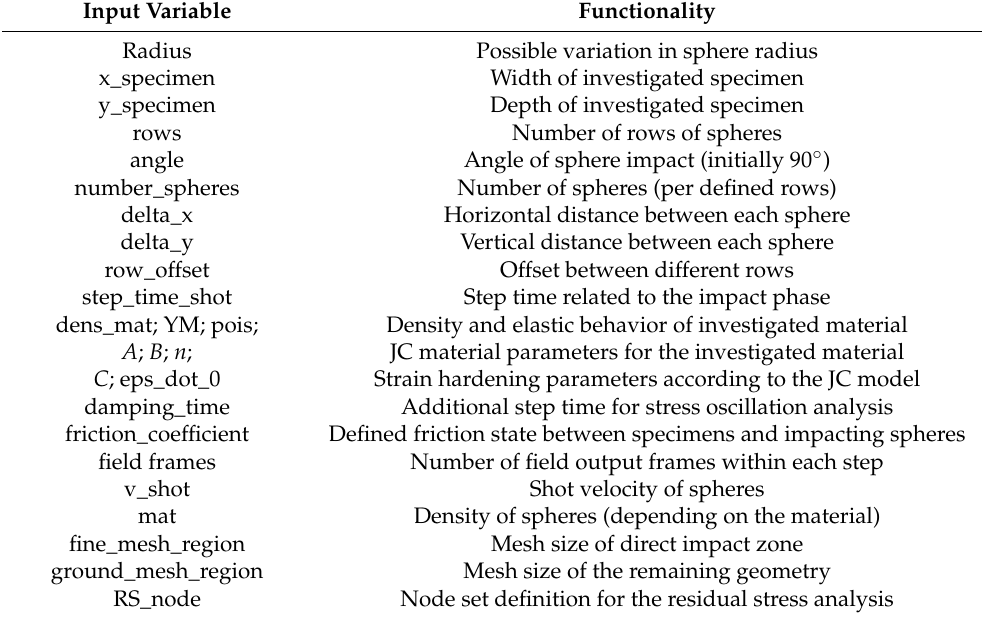
Table 4. Variables changeable within the Python input